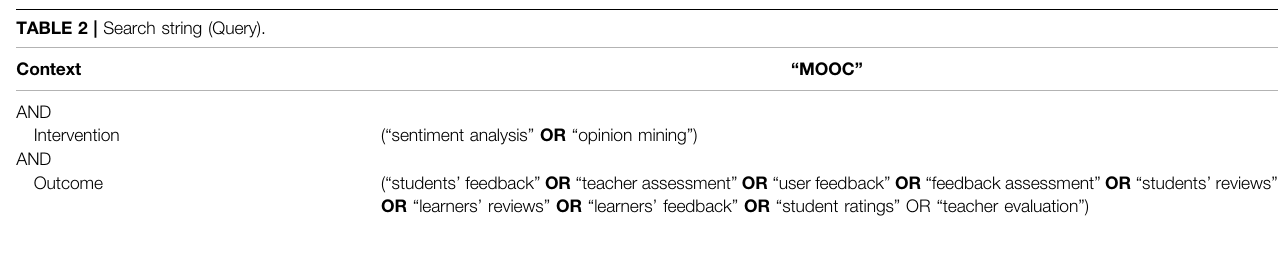
TABLE 2 | Search string